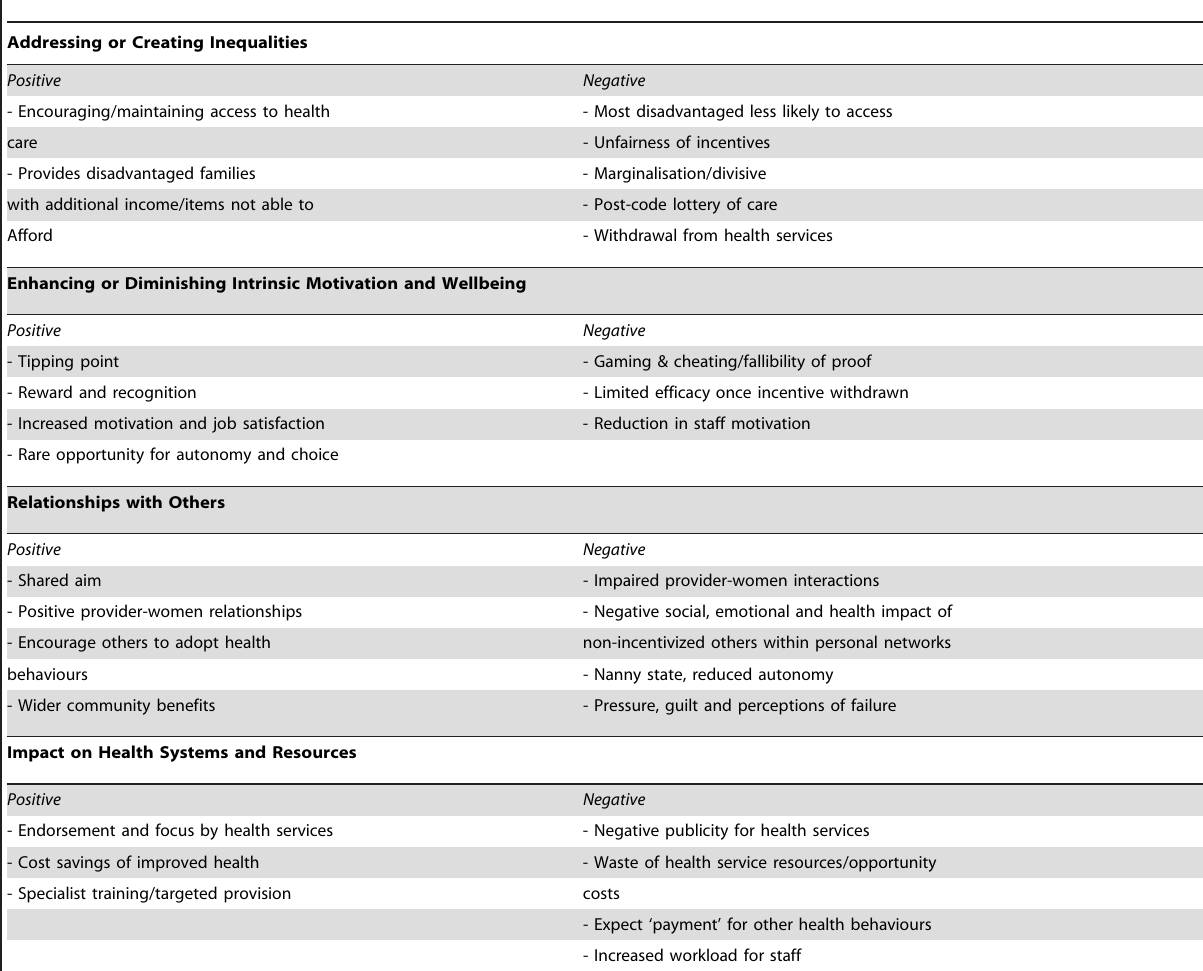
Table 11. Key emergent themes for unintended consequences of